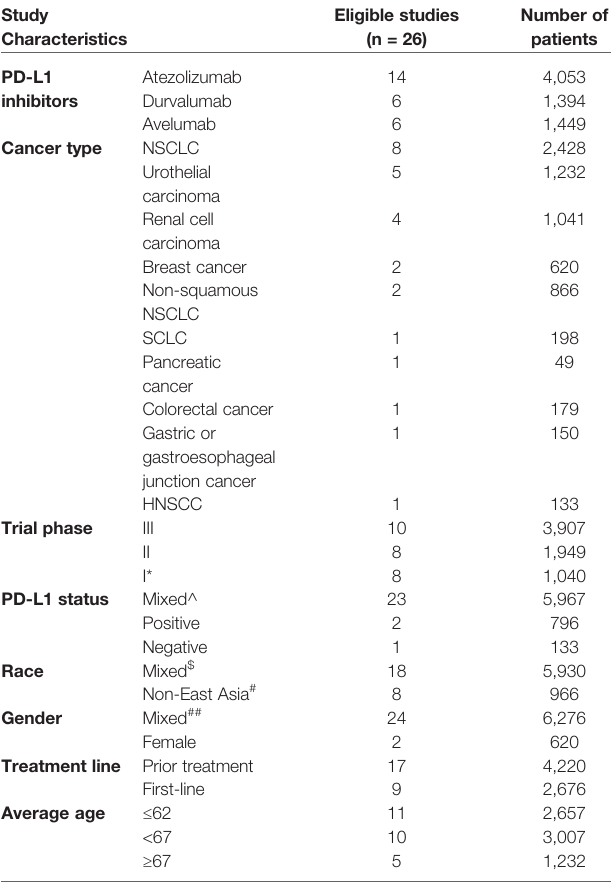
TABLE 1 | Characteristics of eligible